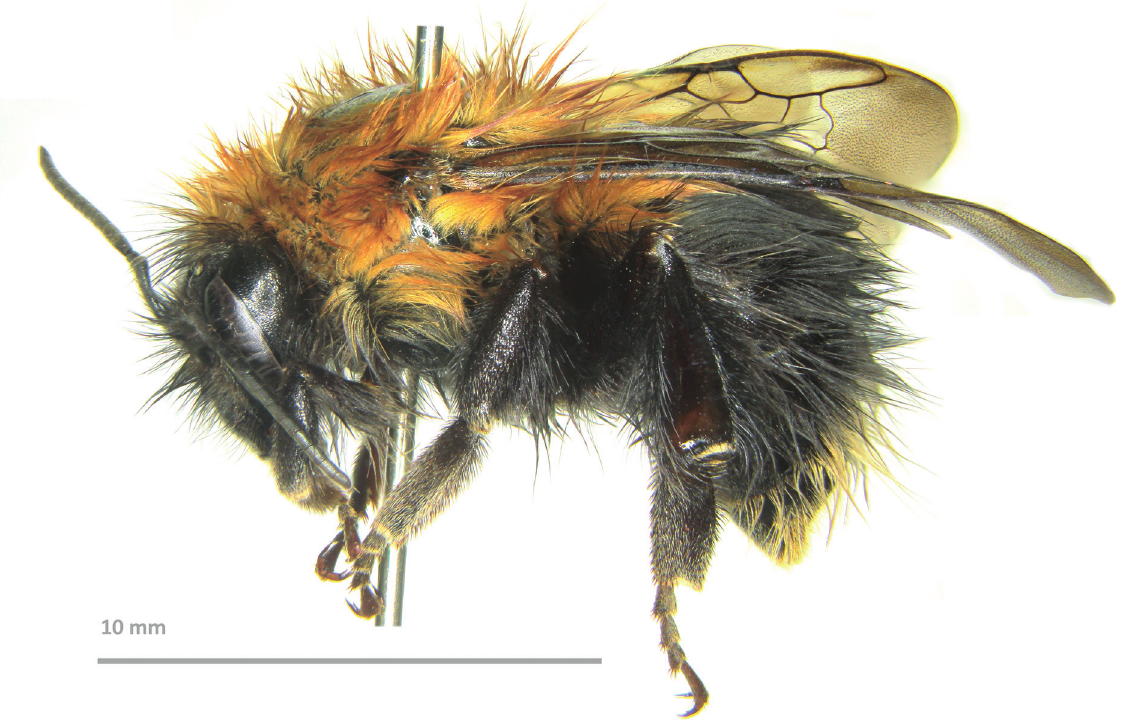
Fig. 52. Bombus hengduanensis Williams, Ren & Xie sp. nov., ♀ (queen), holotype (IOZ), habitus, lateral view (image reversed). Scale bar: 10